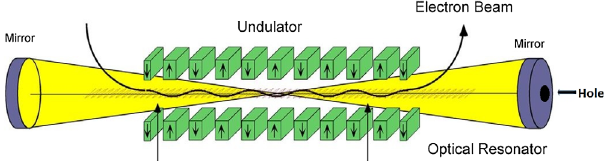
FIG. 1. Schematic showing the oscillator configuration of the free-electron laser. Radiation is out-coupled through a hole in the downstream mirror.